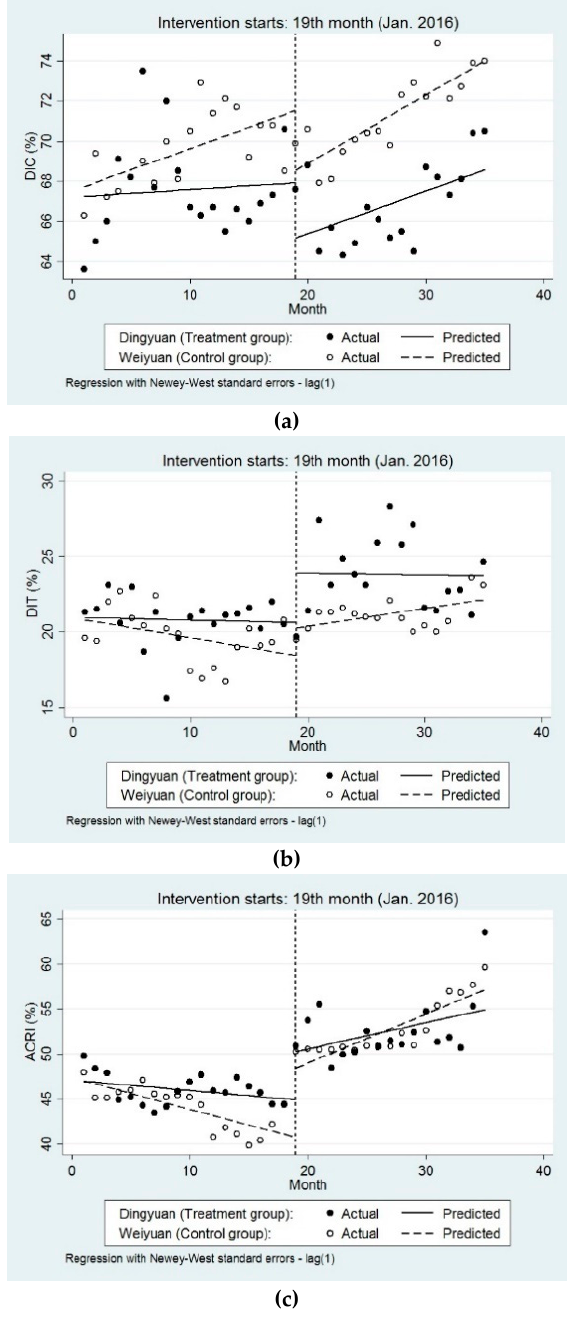
Figure 2. The behavior of inpatients services utilisation over time between two groups. Note: ( a ) DIC in Dingyuan and Weiyuan (%); ( b ) DIT in Dingyuan and Weiyuan (%); ( c ) ACRI in Dingyuan and Weiyuan (%).